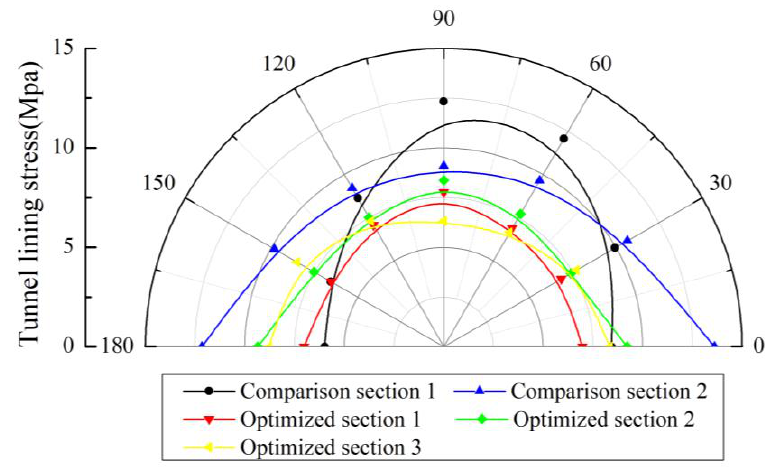
Figure 15. Internal force comparison of tunnel structure before and after adjustments.